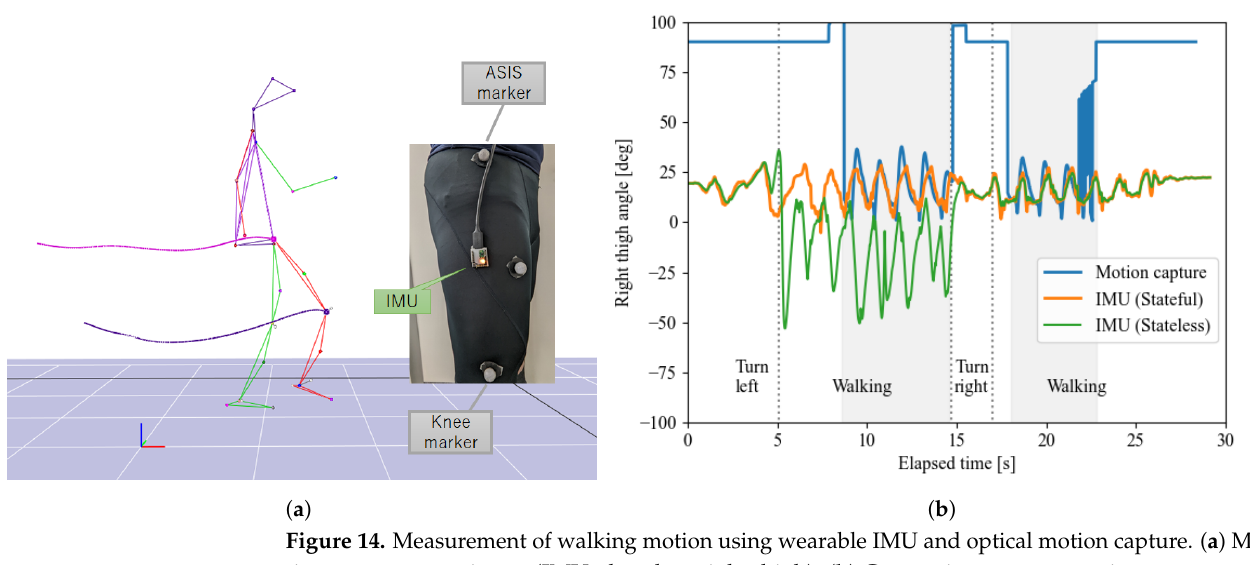
Figure 14. Measurement of walking motion using wearable IMU and optical motion capture. ( a ) Mo- tion capture experiment (IMU placed on right thigh). ( b ) Comparison among motion capture and stateful/less IMU (shaded areas are within the motion capture measurement volume).